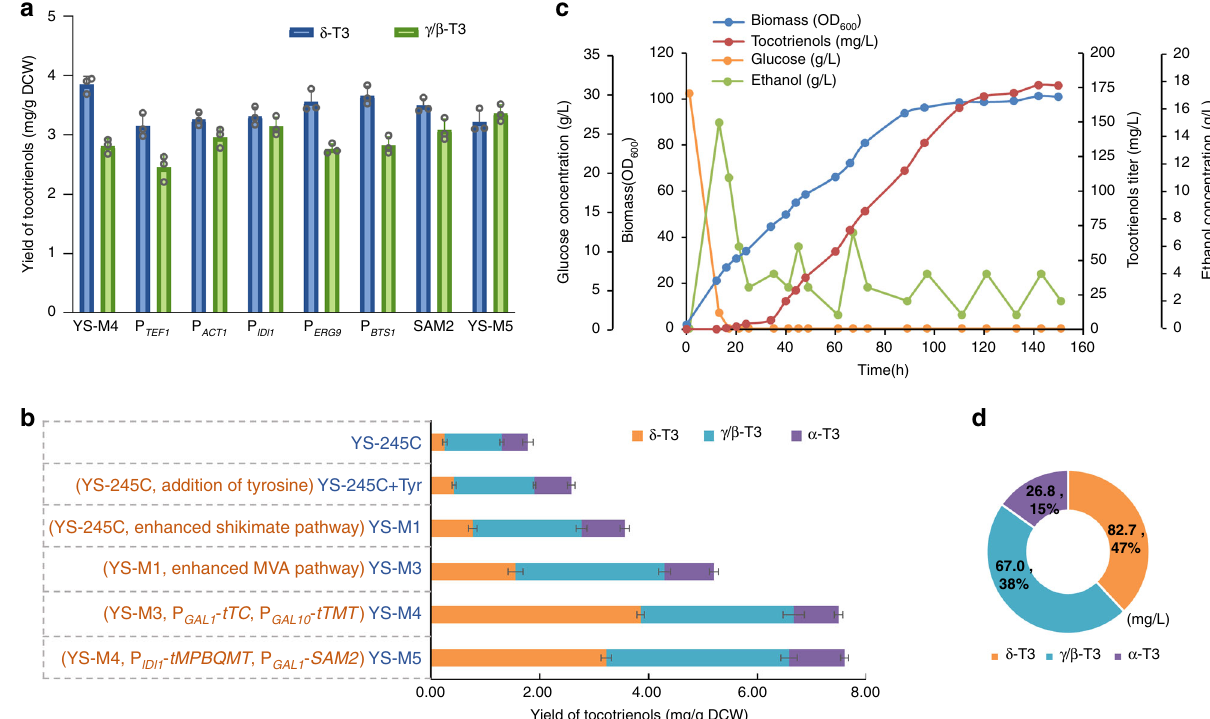
Fig. 6 Comprehensive pathway optimization and fed-batch fermentation. a Effect of tMPBQMT overexpression under different promoters and SAM2 overexpression on δ -tocotrienol and γ -tocotrienol yields. In YS-M4, tMPBQMT was expressed under P GAL10 . In YS-M5, tMPBQMT was overexpressed under P IDI1 and SAM2 was overexpressed under P GAL1 . b Yield and composition of tocotrienols in the engineered yeast strains after stepwise pathway optimization. c Time courses of cell growth, tocotrienols production and consumption of carbon sources during fed-batch fermentation of tocotrienols by YS-M5( + ). d Composition of tocotrienols produced by the end of YS-M5( + ) fermentation. T3, tocotrienol. All values presented are the means of three biological replicates, and error bars represent standard deviations. Source data are provided as a Source Data fi